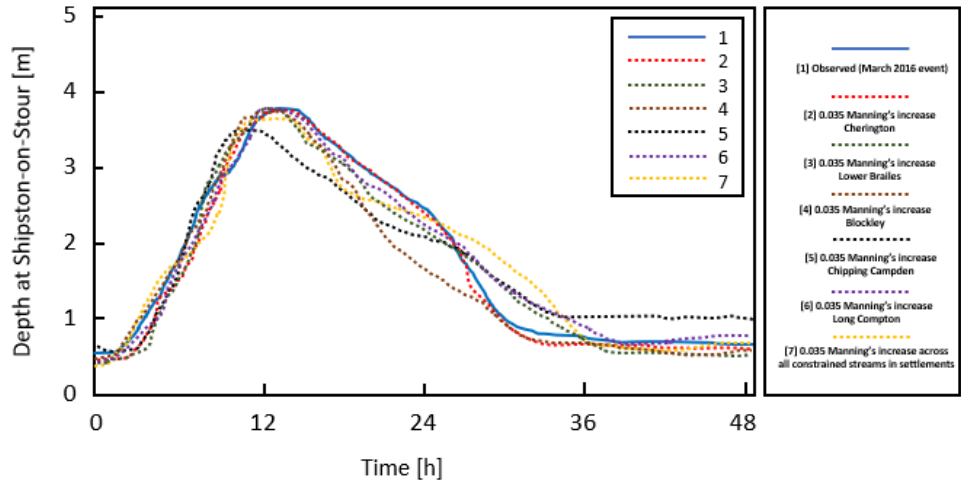
Figure 7. Sensitivity analysis of difference channel roughness scenarios.